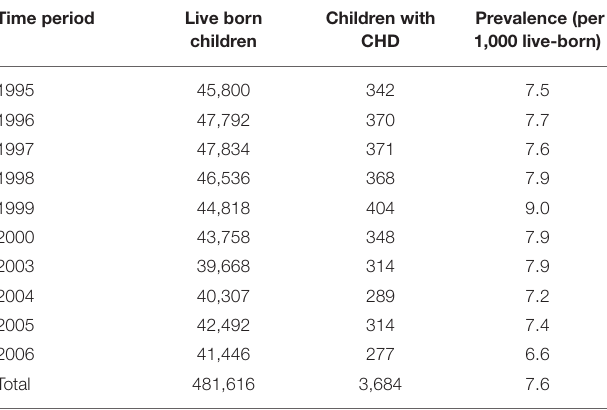
TABLE 1 | Prevalence of congenital heart disease (CHD) in Croatia (1995–2006). Time